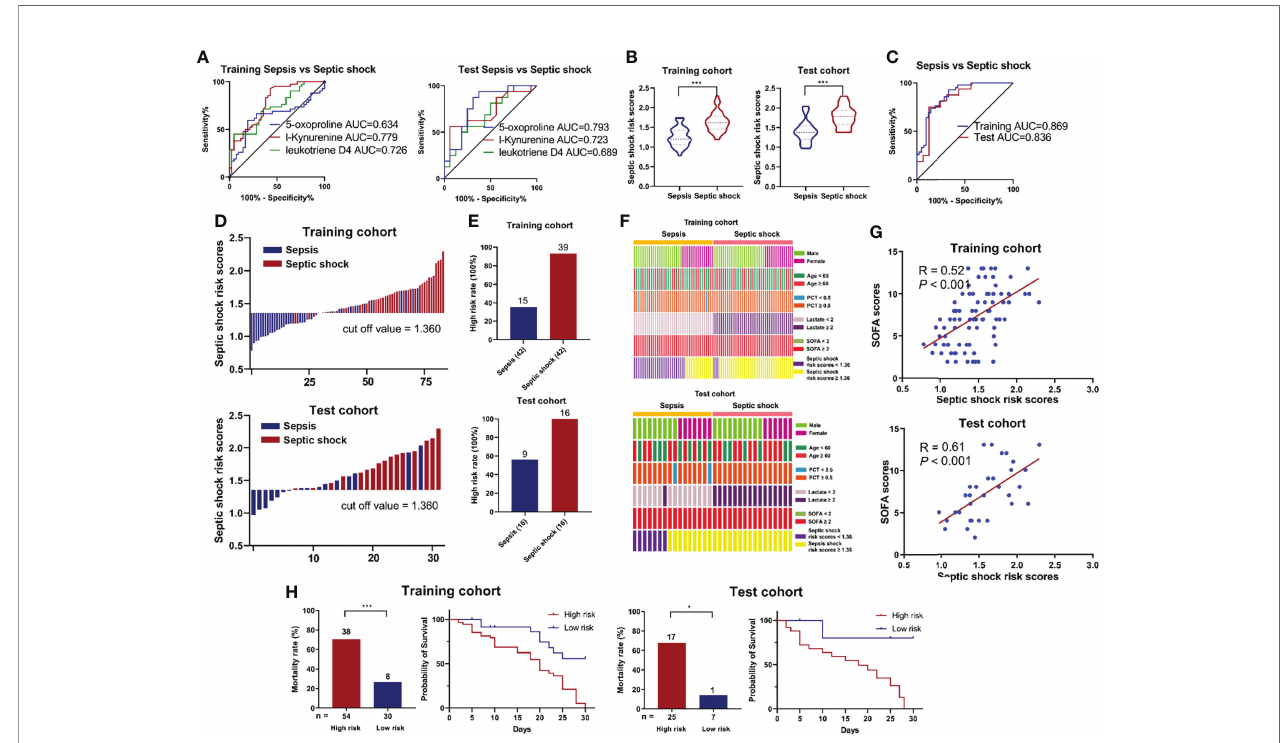
FIGURE 5 | (A) ROC analysis of 5-Oxoproline, L-Kynurenine and Leukotriene D4 in predicting septic shock in the training and test cohorts. (B) Respective values of septic shock risk scores between the septic shock and sepsis groups. The septic shock risk scores were constructed as follows: Ln (septic shock risk scores) = 0.1095 × Ln (5- Oxoproline) + 0.3791× Ln (L-Kynurenine) + 0.2141 × Ln (Leukotriene D4) - 2.2083. (C) ROC analysis of septic shock risk scores in predicting septic shock risk scores. (D) An optimal threshold point value was de fi ned as 1.360, and all participants were divided into low-risk (<cutoff) and high-risk (>cutoff) score groups. (E) Analysis of high risk rate between the septic shock and sepsis groups. (F) Correlation of septic shock incidence and demographic and clinical characteristics, including age, sex, lactate and SOFA scores, and septic shock risk scores. (G) Correlation analysis between septic shock risk scores and SOFA scores. (H) Survival rates after 30 days of patients in the high and low risk groups. (*, p < 0.05; ***, p <